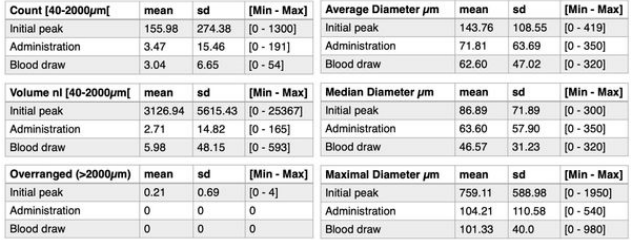
Figure 1: A typical example of a bubble recording with peaks. The light grayline indicates bubbles in the arterial cannula, while dark gray and mid- dle gray are before and after the oxygenator, respecitvely.